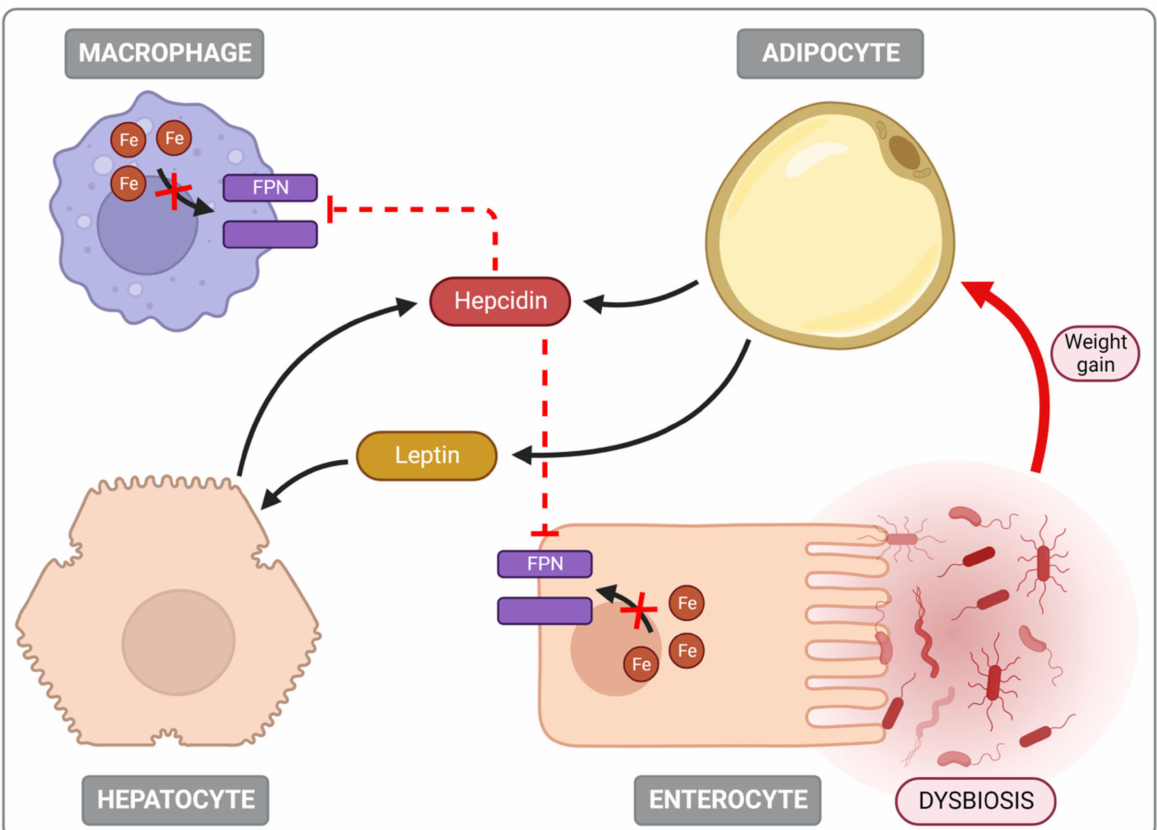
Figure 6. Iron deficiency in people with obesity. FPN—ferroportin, dashed